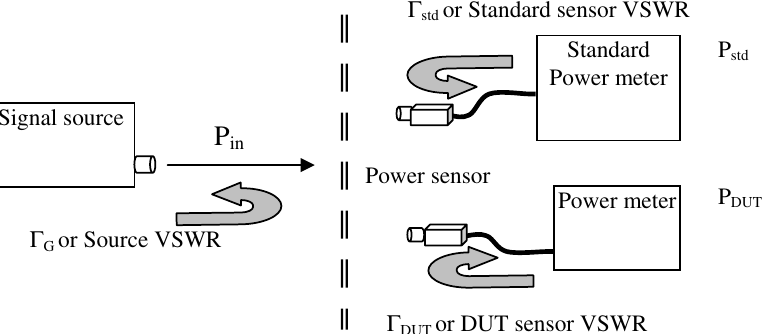
Fig. 2. Differential or null comparison power